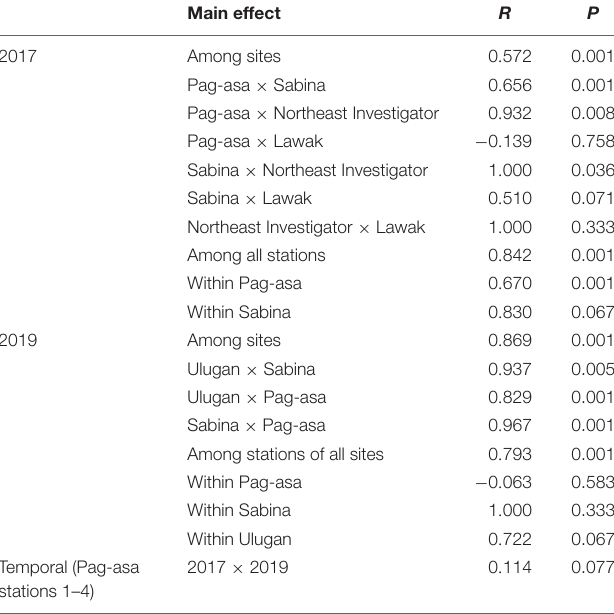
TABLE 2 | Summary result of the Similarity of Percentages (SIMPER) analysis among the sites in the Kalayaan Island Group in 2017. Taxonomic group Average Average abundance similarity